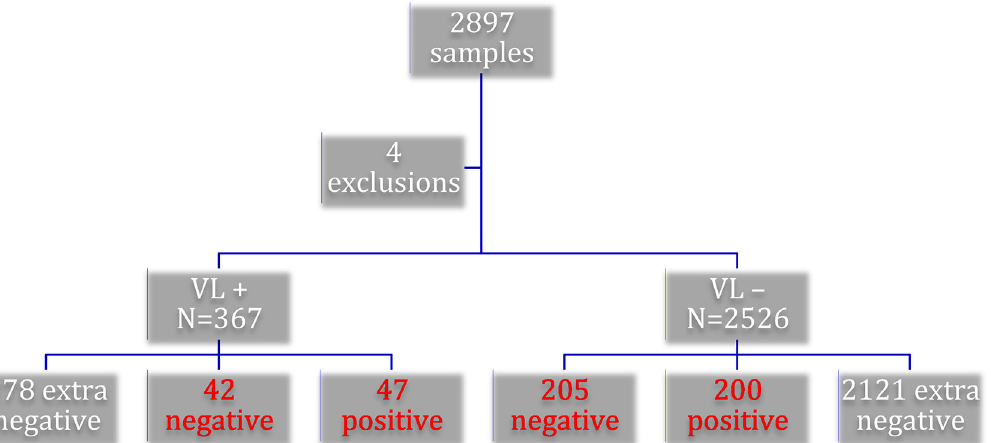
Fig 1. Overview of samples included in final analysis by visceral leishmaniasis (VL) status: Text boxes in red font indicate those samples confirmed by gold standard.